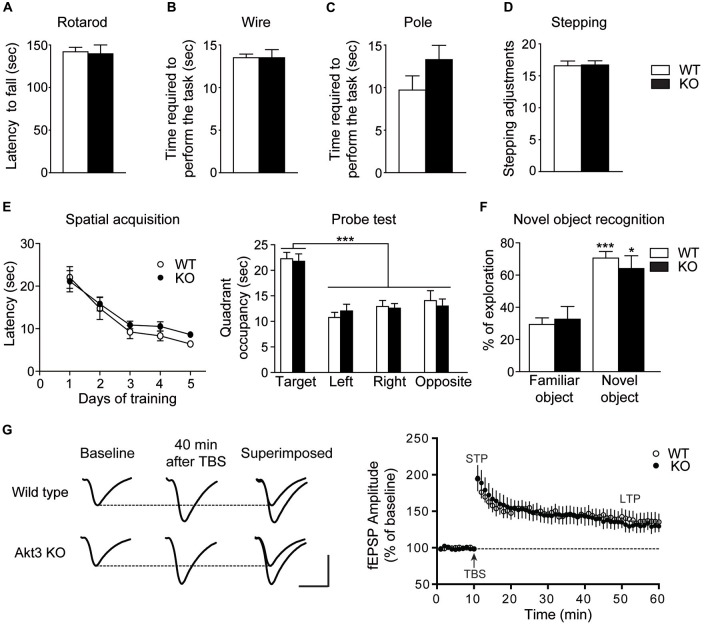
Normal motor abilities and cognitive functions in Akt3 KO mice. Motor abilities on the (A) Rotarod, (B) Pole, (C) Wire and (D) stepping tests of Akt3 KO and wild type (WT) mice were evaluated. Data represent the average mean latency to fall expressed in seconds from three assays (rotarod) ± SEM, n = 7 mice/group. Data represent the mean time require to perform the test (pole and wire) and the mean numbers of adjusting steps (stepping) ± SEM, n = 6–7 mice/group. (E) Mice were trained on the Morris water maze. Spatial acquisition is evaluated by the latency to reach the hidden platform at each day of training expressed in seconds ± SEM, n = 12–17 mice/group. Memory is evaluated during the probe trial by the time spent in each quadrant expressed in seconds ± SEM, n = 12–17 mice/group. ***p < 0.001 vs. target quadrant. (F) The novel object recognition test was performed to evaluate memory. Time spent exploring the familiar or the novel object is shown as a ratio of the total time spent exploring both objects ± SEM, n = 10–11 mouse/group. *p < 0.05, ***p < 0.001 vs. familiar object. (G) Examples of average fEPSPs elicited in the stratum radiatum before and after theta-burst stimulation in WT and Akt3 KO slices. Each sample trace is an average of five consecutive responses. Calibration bar: 5 ms; 1 mV. Amplitude of fEPSPs was measured before and after theta-burst stimulation and fEPSPs were expressed as the percentage of the average response before theta-burst stimulation (arrow). The values obtained during the period preceding theta-burst stimulation were averaged to derive baseline value. The data are expressed as percentages of baseline values and each point represents the mean ± SEM, n = 7.